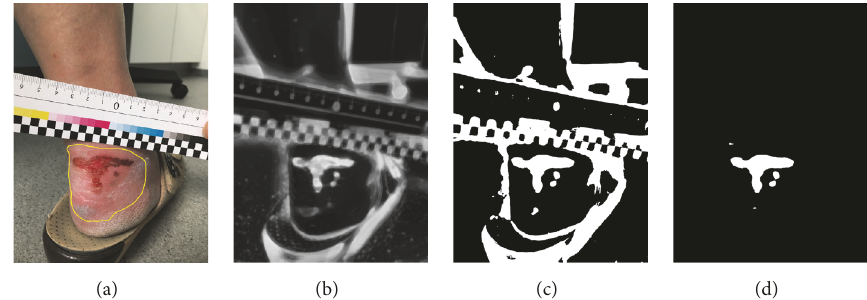
Figure 1: (a) Original image. (b) Probability map (result of Random Forest classifier). (c) The result of Otsu’s filter. (d) Segmentation result after applying the ROI.